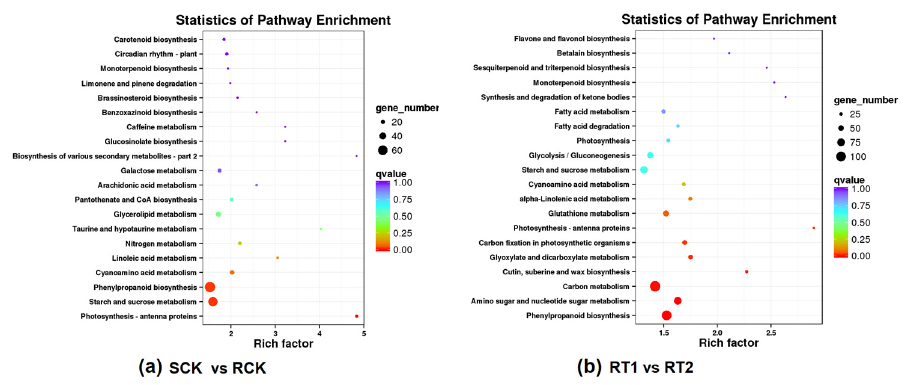
Figure 3. DEG enrichment of the KEGG pathway: ( a ) SCK vs. RCK; ( b ) RT1 vs. RT2.